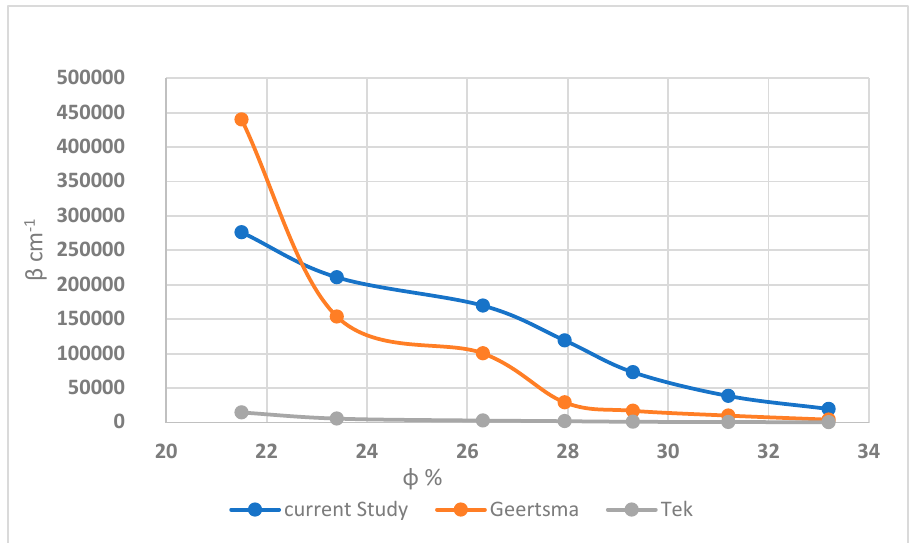
Figure 12. The non-Darcy coefficient with the effect of tortuosity for the seven samples resulted from two different air and water experiments.